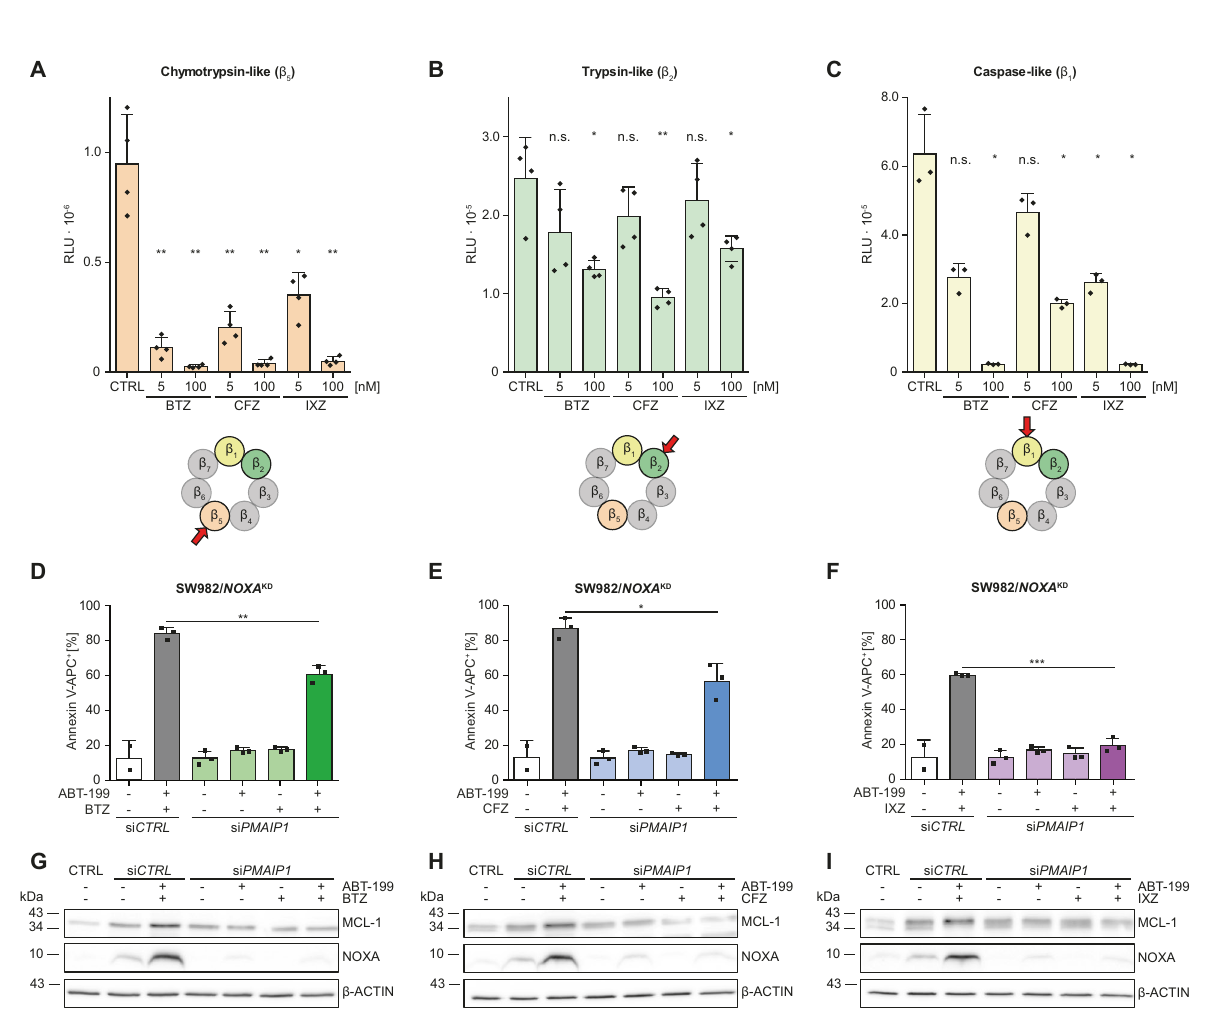
Fig. 2 PI speci fi city modulates NOXA dependent synergistic cell death induction. A – C SW982/WT cells were pre-incubated for 4 h with 5 nM or 100 nM of BTZ, CFZ or IXZ and Proteasome-Glo TM cell based reagent was added. Luminescence indicating activity of the individual proteasomal subunits was detected after 5 min of incubation. D – F SW982/WT were transfected with PMAIP1 siRNA and subsequently incubated for 24 h in the presence or absence of 15 µM ABT-199 and/or 5 nM PI (BTZ, CFZ or IXZ). Apoptotic cell death was assessed fl ow cytometrically by detecting Annexin V-APC + cells. Graphs represent mean values and individual data points. Statistical signi fi cance was calculated by an unpaired student´s t test. G – I After treatment with 15 µM ABT-199 and/or 5 nM PI (BTZ, CFZ, IXZ; + 10 µM Q-VD-OPh) for 8 h each 40 µg total protein per lane were separated on a 12 – 20% polyacrylamide gradient gel and knock-down of NOXA, with β -ACTIN as loading control, was veri fi ed by Western blot. BTZ bortezomib, CFZ car fi lzomib, IXZ ixazomib, CTRL control. To test whether ABT-199 mediates enhanced transcription we expression of NOXA from NOXA stabilization by proteasome analyzed PMAIP1 mRNA by real-time PCR. Astonishingly, ABT-199 inhibition we co-applied cycloheximide (CHX) to block protein induced 10-fold expression of PMAIP1/ NOXA that was even further synthesis. CHX abolishes PI induced NOXA expression (Fig. 3D, enhanced (>25-fold) in response to ABT-199&BTZ. This enhanced upper panel) indicating that enhanced expression of NOXA is transcription of PMAIP1/ NOXA was blocked when transcription based on protein synthesis. Intriguingly, strong expression of was blocked by actinomycin D (Act-D) (Fig. 3E, bar graph). NOXA in response to ABT-199 (without or with PIs) is blocked by Transcriptional regulation was further investigated by analyzing CHX and thus also relies on protein synthesis (Fig. 3D, lower the impact of ABT-199 on expression of transgenic NOXA in panel).